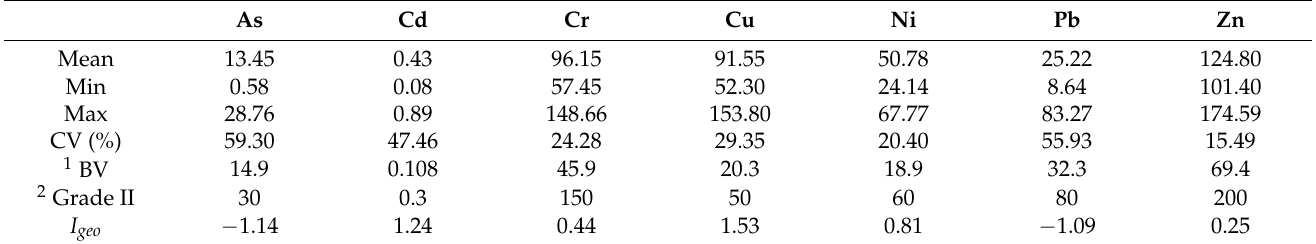
Table 2. Contents (mg/kg) and Igeo values of heavy metals in farmland